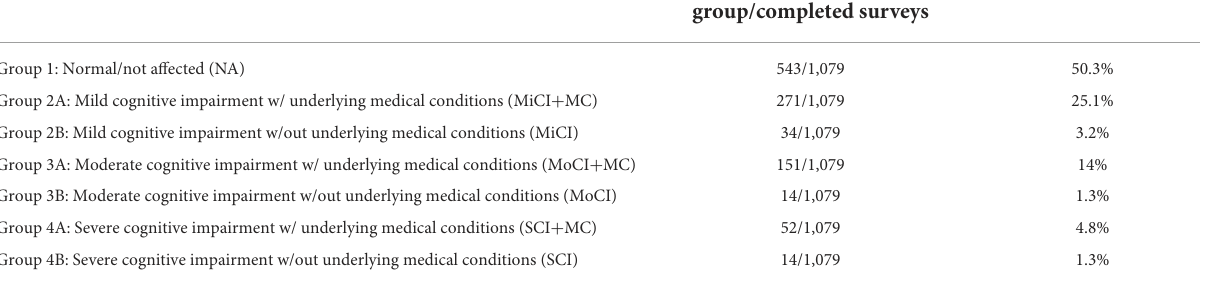
TABLE 1 Definition of each group and the number of dogs per group out of the number of completed surveys.